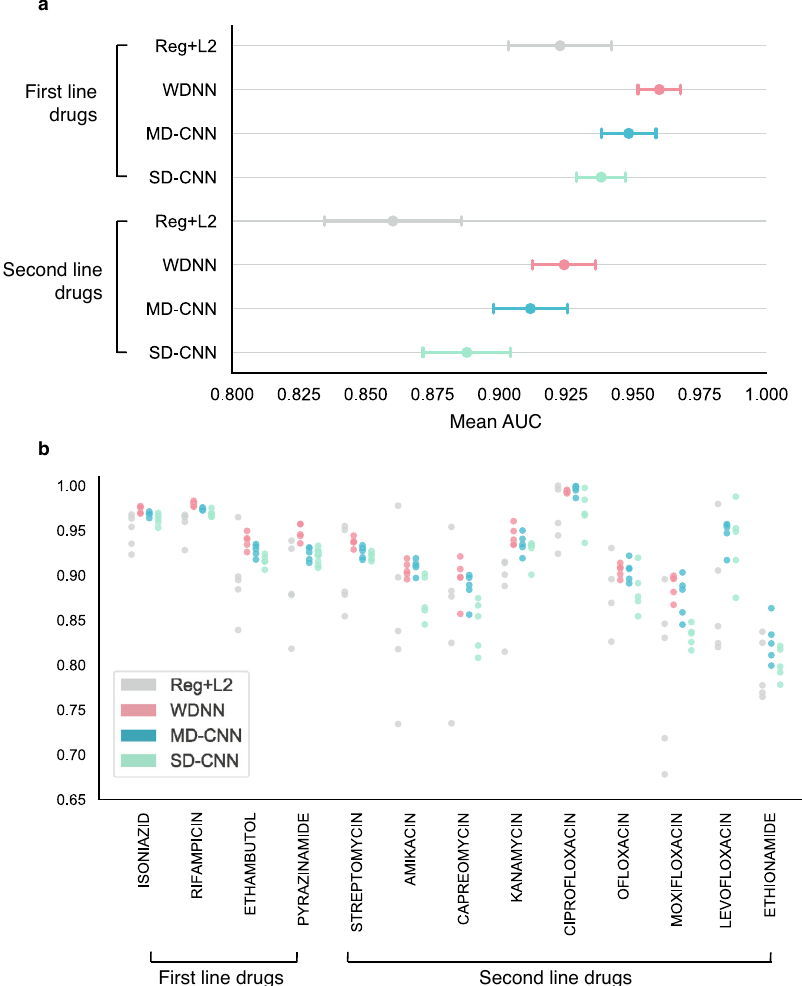
Fig. 2 MD-CNN performs comparably to state-of-art WDNN for both fi rst- and second-line drugs. Results of fi ve-fold cross validation on the training dataset ( N = 10,201 isolates) for the four models: WDNN, logistic regression + L2 benchmark, SD-CNN, and MD-CNN. a Data are presented as pooled mean AUCs ± 95% con fi dence intervals for fi rst-line (5 AUC values per drug, 4 drugs) and second-line drugs (5 AUC values per drug, 9 drugs). b data are presented as individual AUC values for each cross-validation split. The WDNN was not initially trained on levo fl oxacin or ethionamide and thus was not evaluated for these